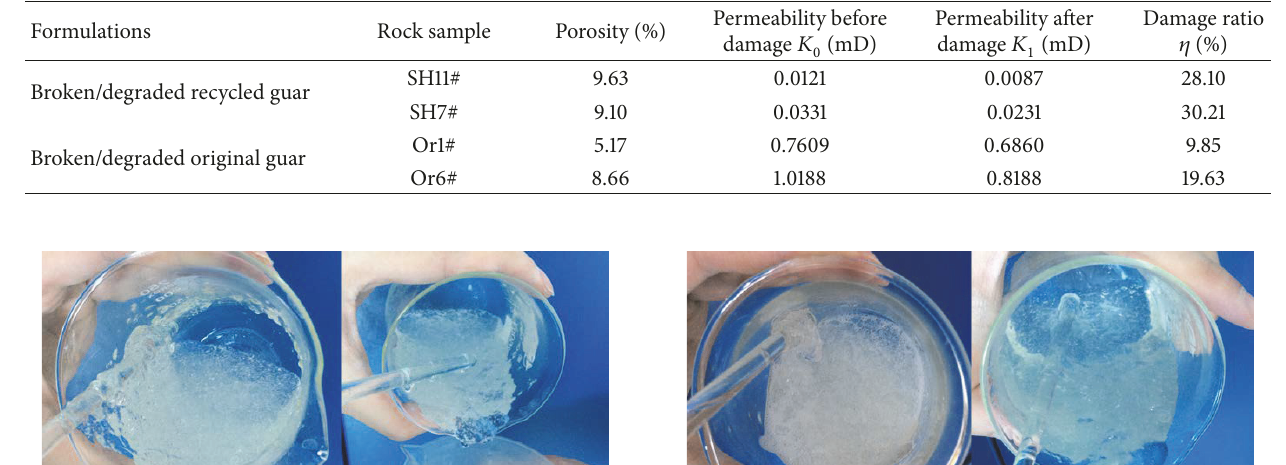
Table 5: Comparison of rock permeability damage due to different fracturing fluids.